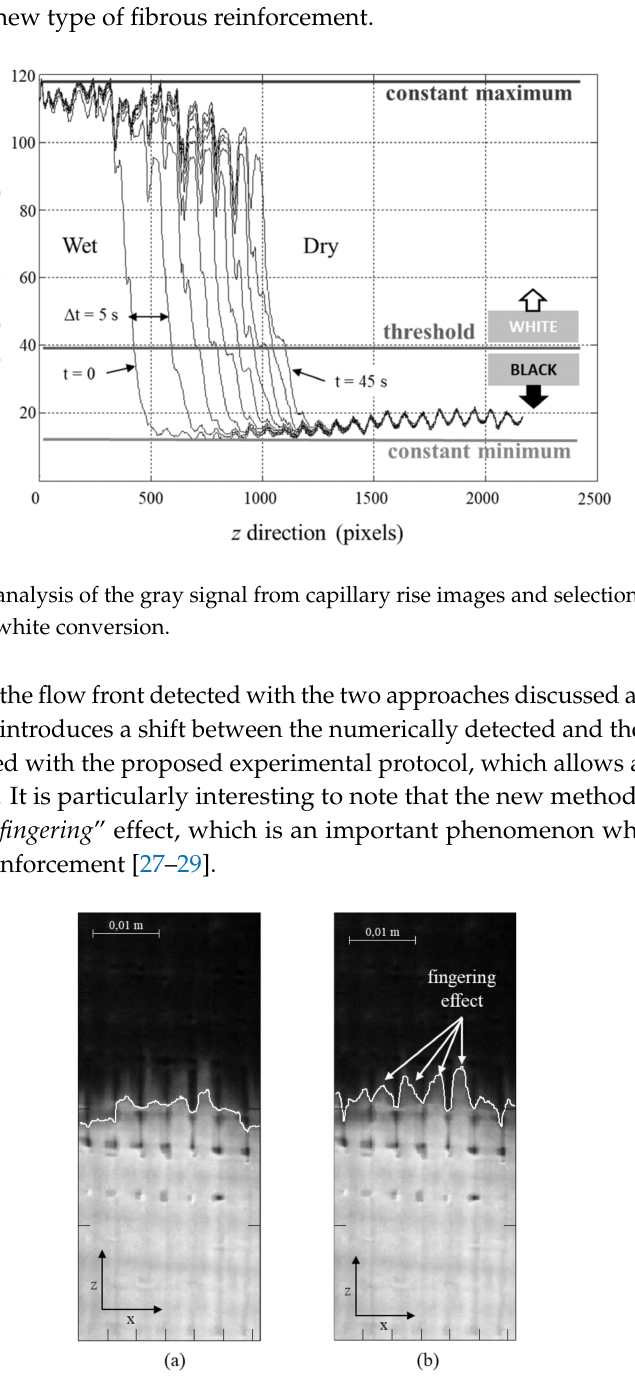
Figure 5. Detection of the fluid front during capillary rise experiments: ( a ) with Otsu’ algorithm; ( b ) with the approach developed in this